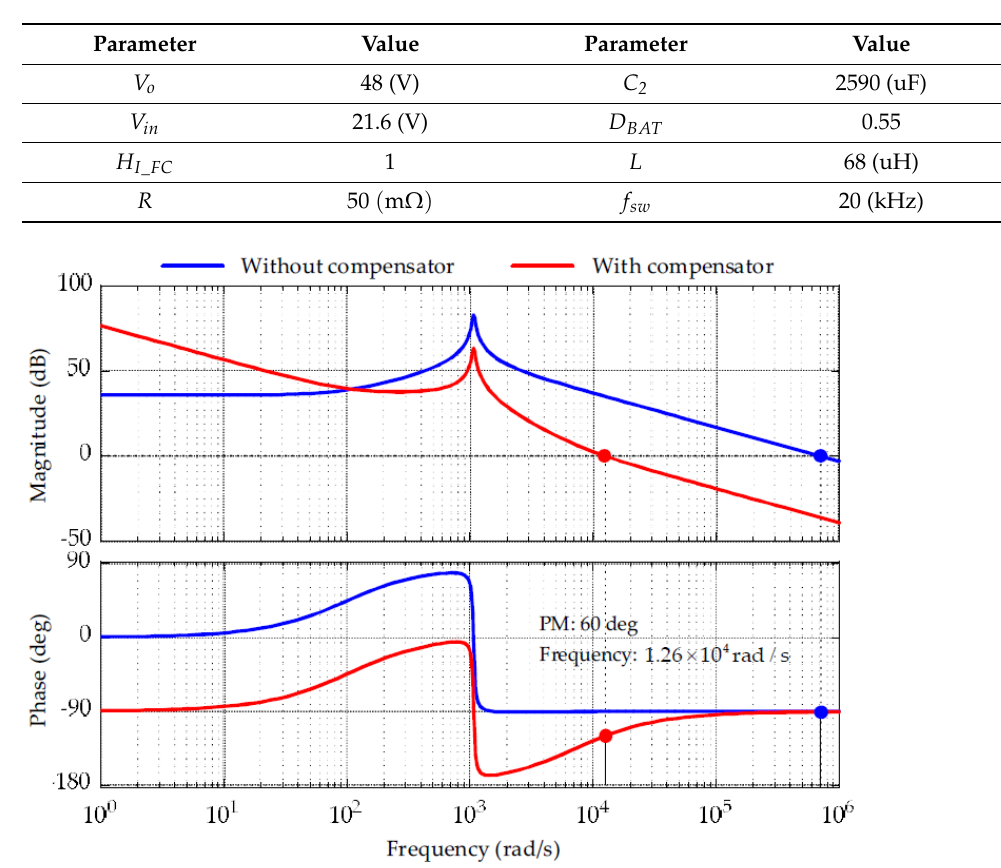
_ pi BAT G Figure 12. Block diagram of the controllers for BAT converter. The PI compensator of the BAT current control loop (PI-3 controller) is given as